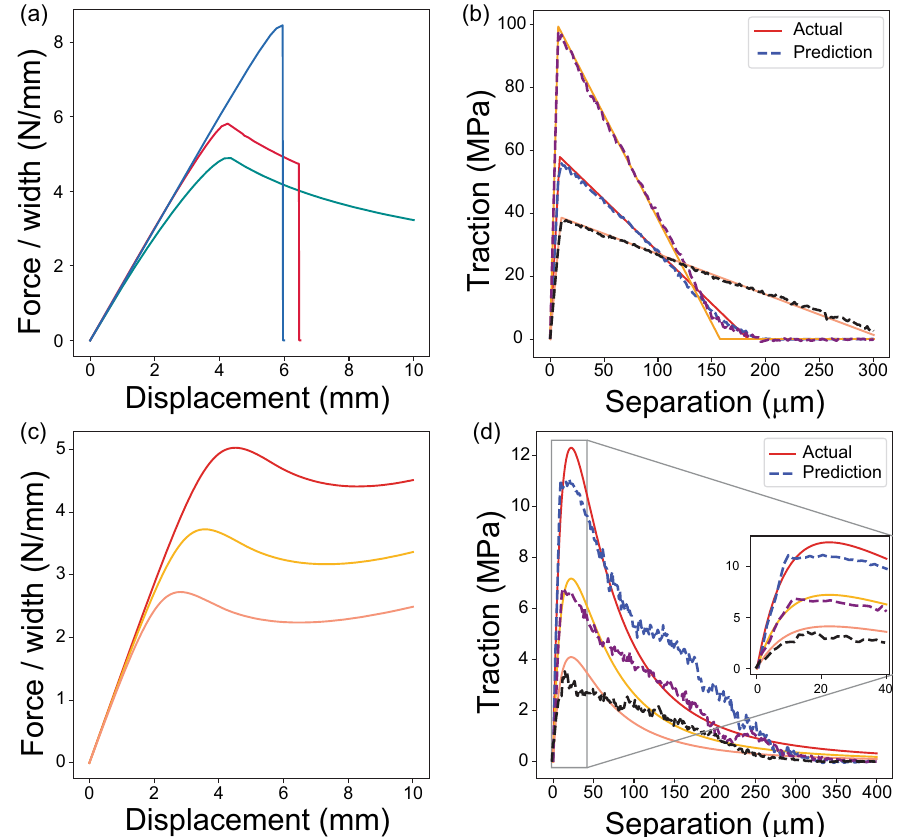
Figure 2. Machine learning on FEA data. ( a ) Different types of F–D curves obtained from triangular T–S relations, ( b ) comparison between triangular T–S relations predicted by XGBoost ML and the actual cases preset in FEA, ( c ) the F–D curves calculated based on different Leonard-Jones T–S relations, and ( d ) the prediction results using the F–D curves in ( c ) and comparison with preset T–S relations.